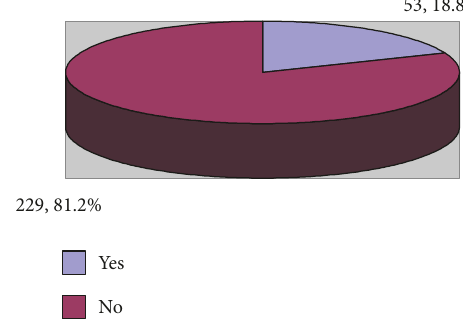
Figure 1: Smoking history of the emergency department physicians and nurses.